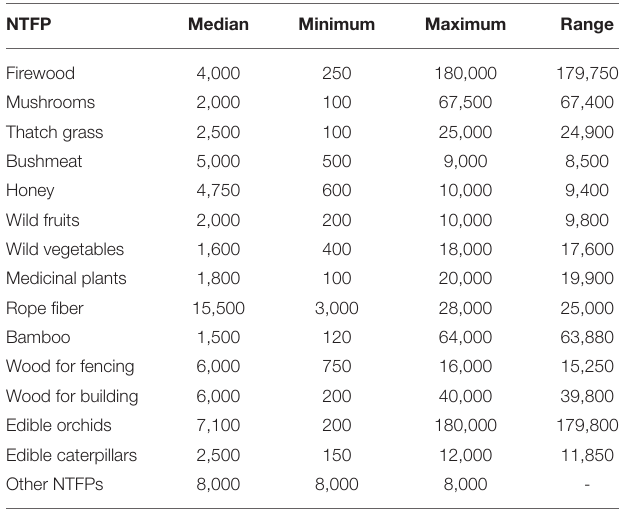
TABLE 5 | Annual cash income generated from selling multiple NTFPs (Mk/year; US$1 = Mk395). No. of NTFPs